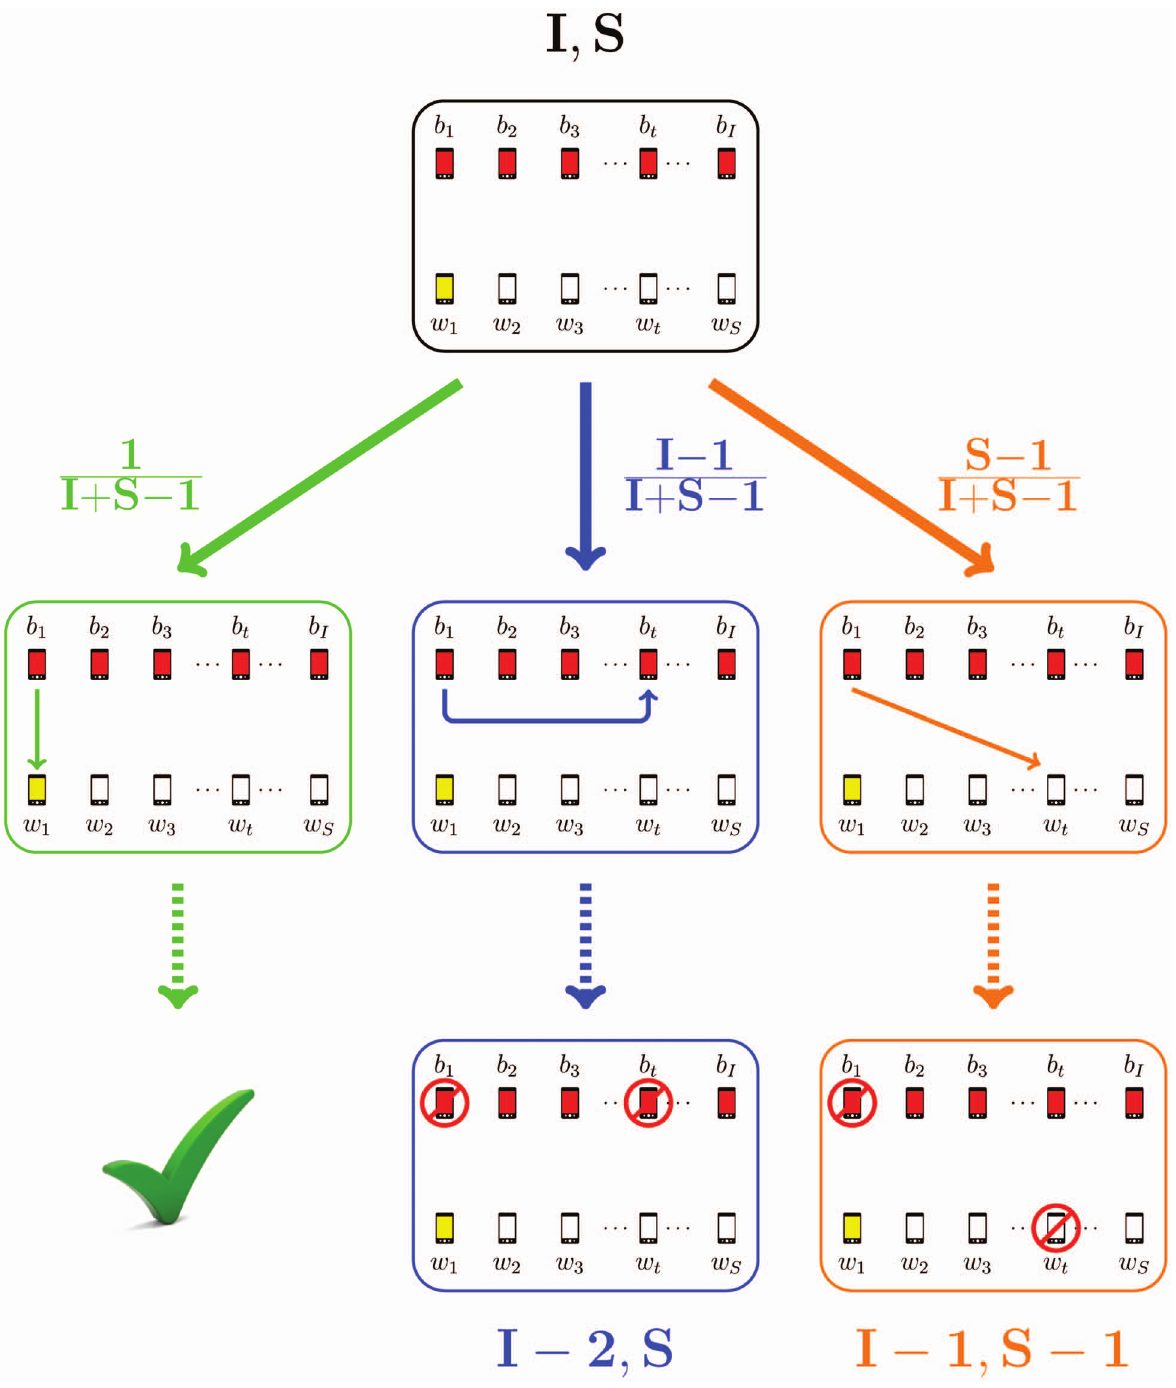
Figure 3. Construction of the general case of the recursive formula Eq. 1. Starting from the initial configuration ( I , S ) , we want to compute the probability P ( I , S ) that a clean mobile ( w 1 without loss of generality) gets infected in the proposed model. At time t , the first infected mobile b